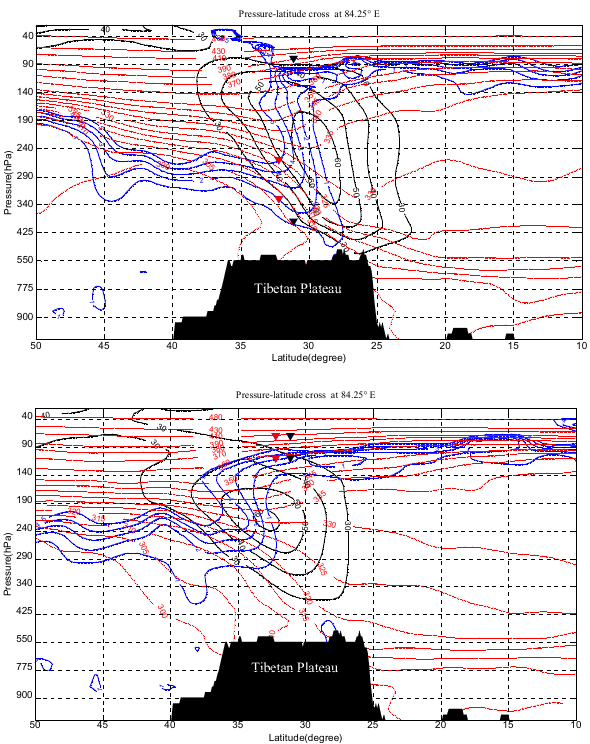
Fig. 5. (a) Meridional cross-section at 84.25 ◦ E (over Gerze site) on 25 February 2008, 12:00LT between 10 ◦ N and 50 ◦ N in lati- tude and between 1000hPa and 20hPa in the vertical derived from ERA-40 data, including zonal winds (black contours, m/s), poten- Fig. 5. (b) same as Fig. 5. (a) but for 29 Feb. 2008, 12:00 LT. tial vorticity (PV) (blue lines, contours of 1–5PVU units) and po- tential temperature (red contours, K). The red and black triangles were tropopauses observed at Gerze and Nagqu station. (b) same as Fig. 5. (a) but for 29 February 2008, 12:00LT.